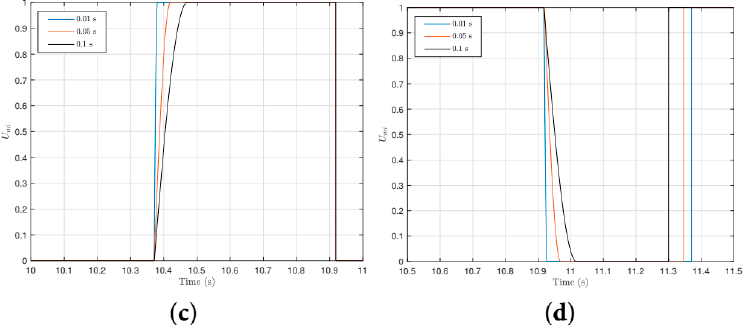
Figure 8. The effect of mitral valve opening and closing time. ( a , b ) show, respectively, the effect of opening and closing time on the P-V loop, respectively, and ( c , d ) show traces of U mi for different opening and closing times (refer to Section 2.4 for an explanation of U mi ). ( a ) The effect of mitral valve opening time on the P-V loop. ( b ) The effect of mitral valve closing time on the P-V loop. ( c ) Time traces of U mi for different opening times. ( d ) Time traces of U mi for different closing times.